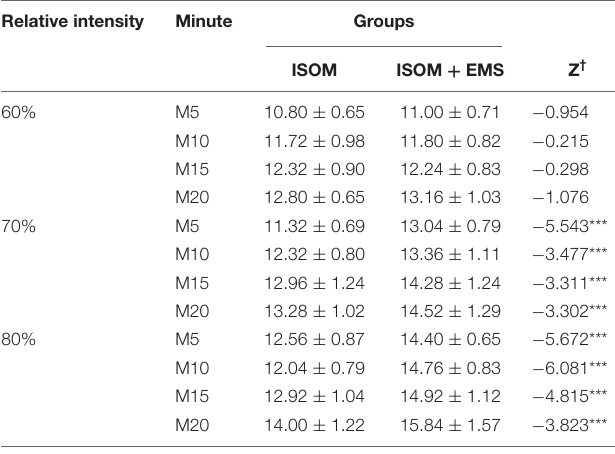
TABLE 4 | Comparison result of RPE levels every 5 min for three exercise intensities in two exercised groups. Relative intensity